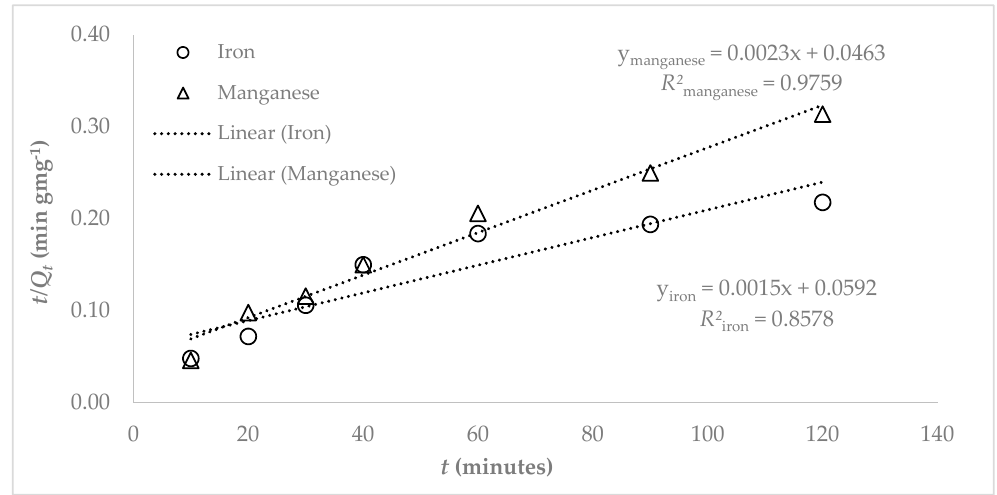
Figure 10. Pseudo first-order kinetic model obtained for adsorption of iron and manganese on to zeolite Y. Initial Fe = 1.15 mg L − 1 ; Initial Mn = 1.61 mg L − 1 ; adsorbent dose = 2 g L − 1 , T = 25 °C; water pH = 6.5.